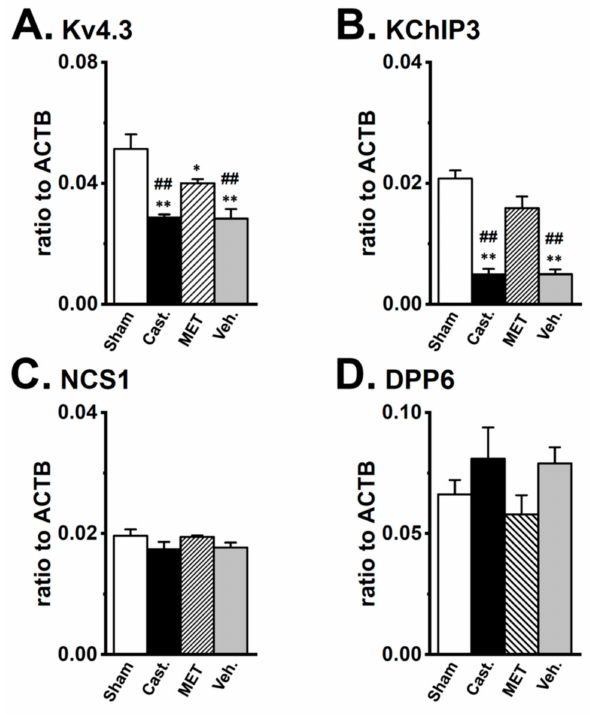
Figure 5. Changes in the transcriptional expression of Kv4 α and Kv4 β by castration in rat VDSMs. The expression of Kv4.3, KChIP3, NCS1, and DPP6 transcripts in each group was examined by real-time PCR analysis. Values are shown for steady-state transcripts relative to ACTB in the same preparation. group ( Sham ), black columns—castrated group ( Cast. ), hatched columns—MET-treated group ( MET ), and gray columns—vehicle-treated group ( Veh. ). *, ** p < 0.05, 0.01 versus Sham; ## p < 0.01 versus